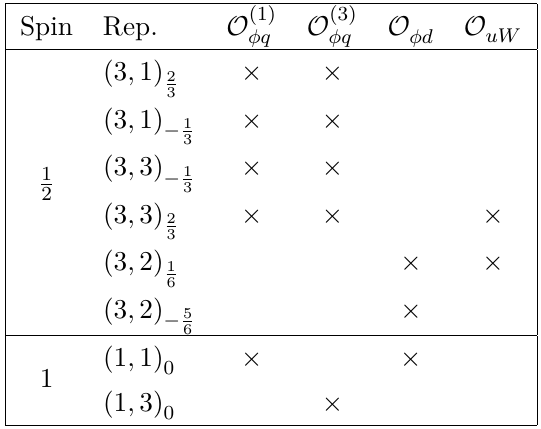
Table 6 . ψ 2 φ 2 D and ψ 2 Xφ operators generated from additional fermion or vector